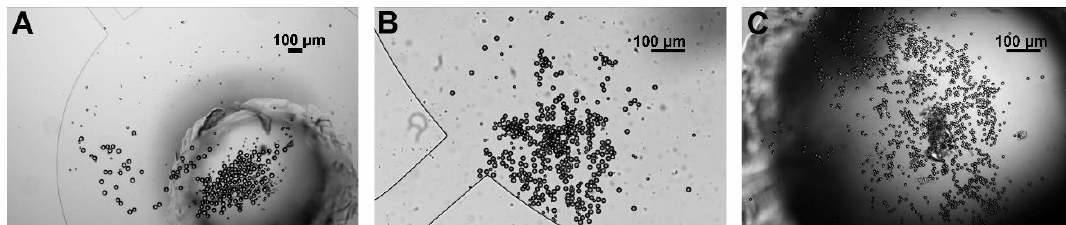
Figure 8. Particle collection results: ( A ) particles in the first-stage collection area; ( B ) particles in the second-stage collection area; and ( C ) particles in the outlet reservoir.